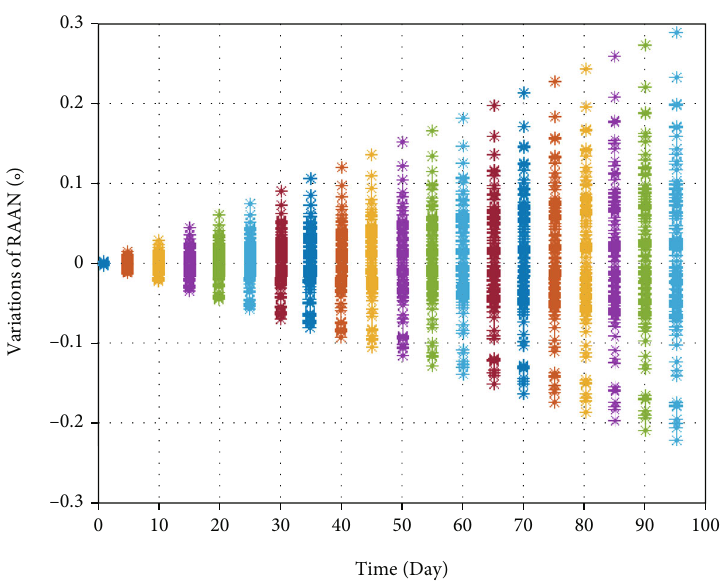
Figure 9: Variations of RAAN ( h = 550km , i = 53 °